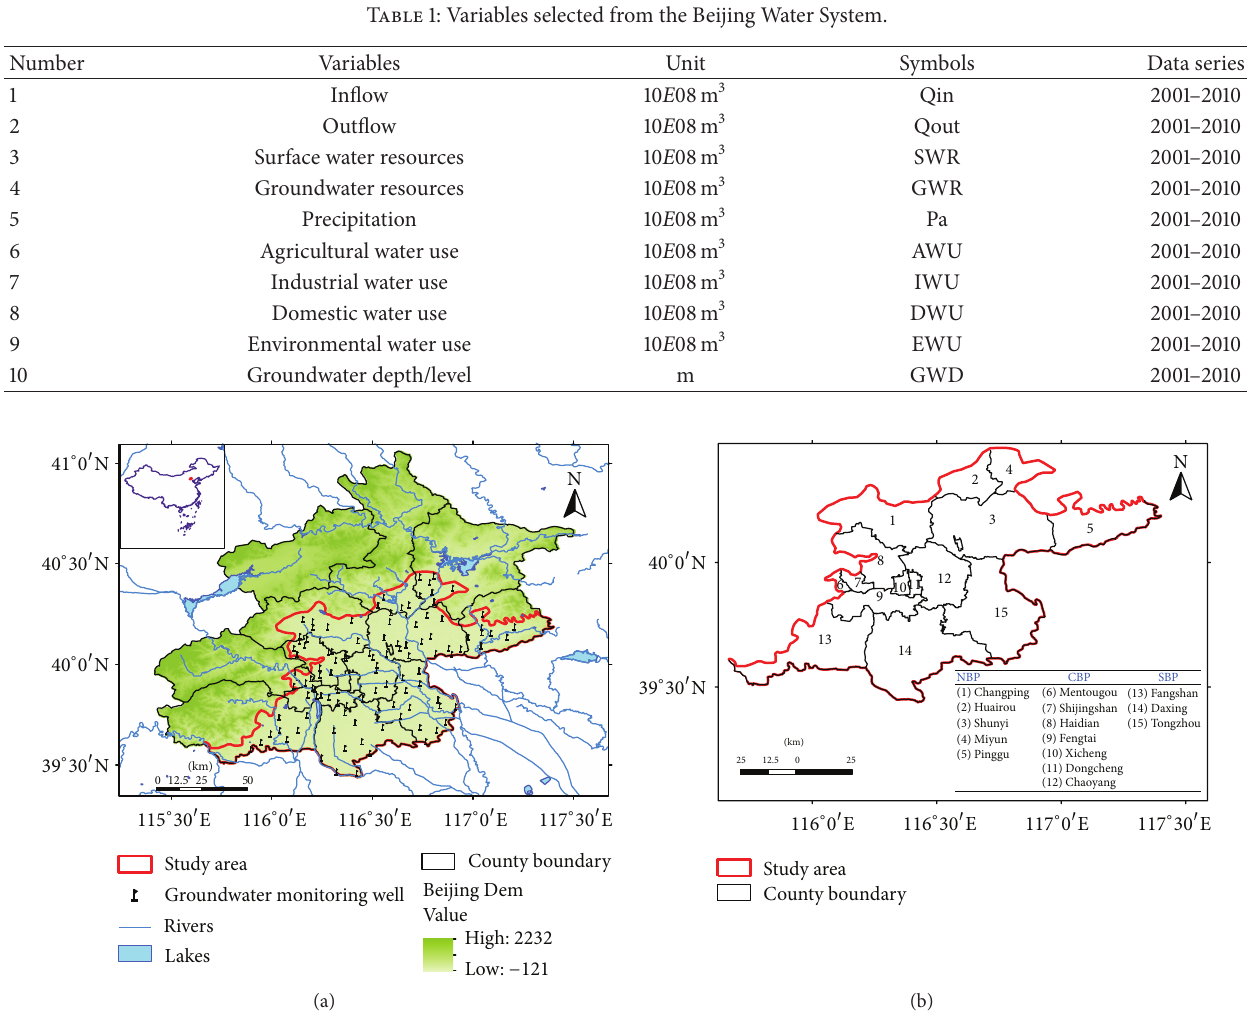
Figure 1: (a) Location of the study area and the 106 groundwater monitoring wells in Beijing Plain. Red solid lines denoted the boundary of study area, namely, Beijing Plain. (b) Subareas division of Beijing